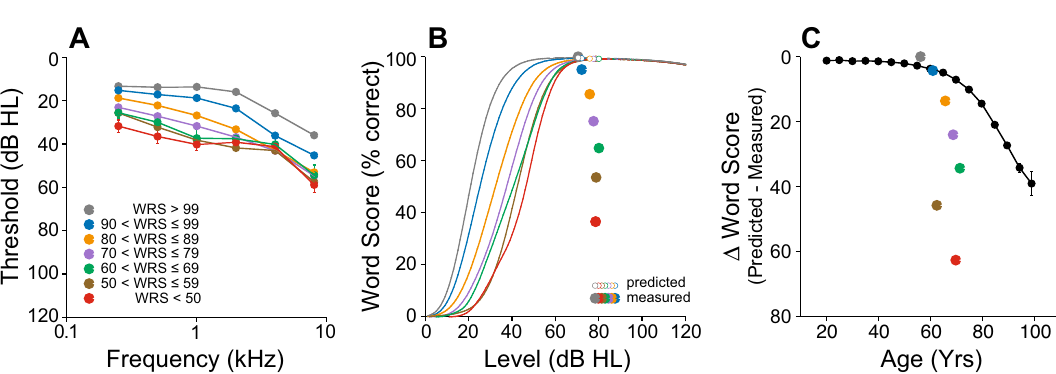
Figure 5. Massive intelligibility deficits can be associated with moderate hearing loss. ( A ) Mean air-conduction thresholds at standard audiometric frequencies from all patients with sensorineural hearing loss whose word recognition performance is predicted ≥ 99% by the speech intelligibility curve as a function of measured word recognition score. ( B ) Speech intelligibility curves for each subgroup of patients described in ( A ) with their associated predicted and measured word recognition score. ( C ) Intelligibility deficits assessed by calculating the difference between measured word score and score predicted by the speech intelligibility curve in each subgroup of patients described in A as a function of age. Error bars are standard error of